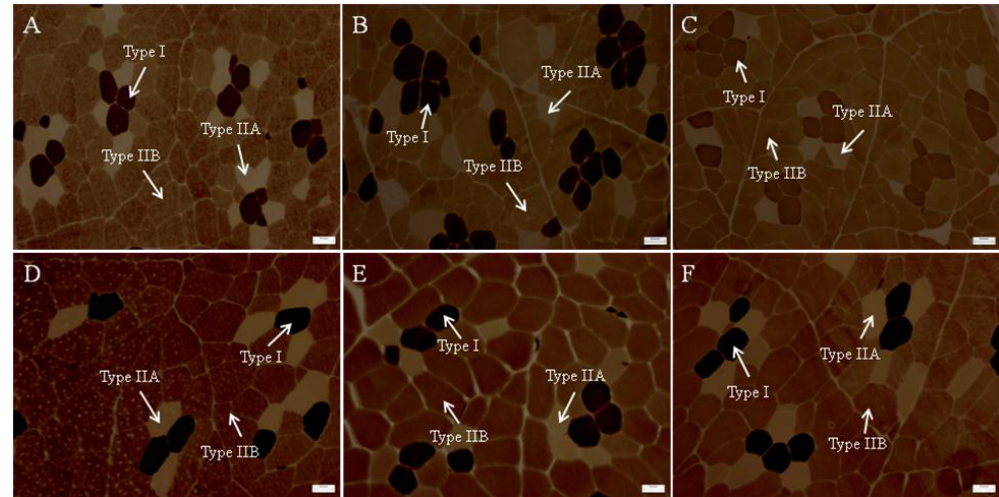
Figure 2. Distribution of muscle fiber types of the longissmus dorsi muscles in crossbred pig (KNP  Landrace) F 2 . Serial sections of muscles were stained for myosin ATPase reactivity after preincubation at pH 4.65. Magnification of 100  was used (Bar = 50  m). A: Black, B: White, C: Red, D: White spot in black, E: Black spot in white, F: Black spot in